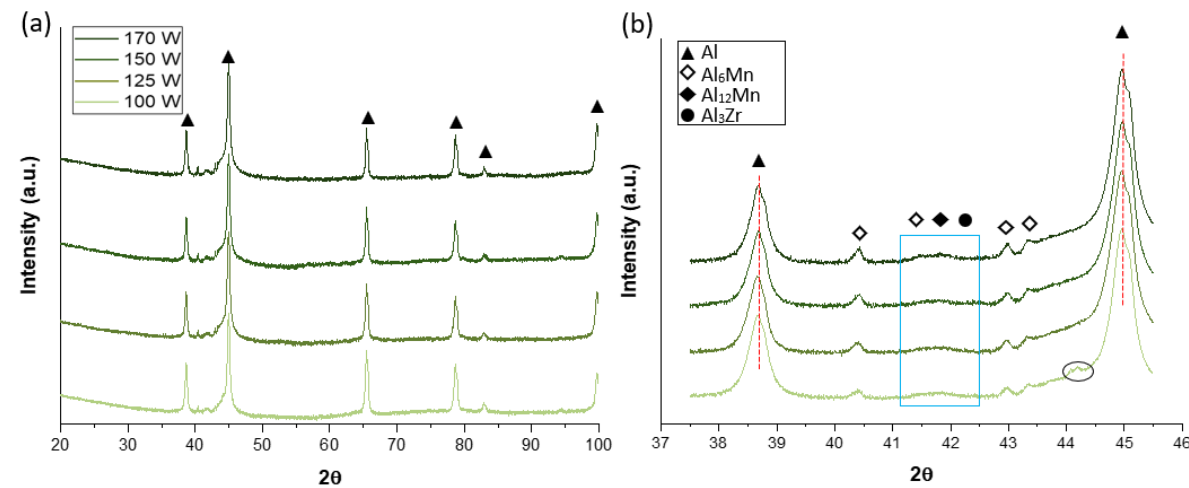
Figure 12. The complete XRD patterns for each power condition ( a ) and the detailed analysis in a 2ϑ range of 37.5–45.5 ◦ ( b ).